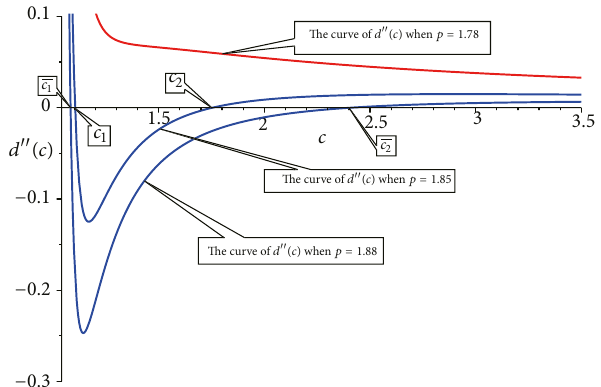
Figure 5: The curve image of 𝑑 󸀠󸀠 (𝑐) when 𝑝 = 1.78,1.85, 1.88 .